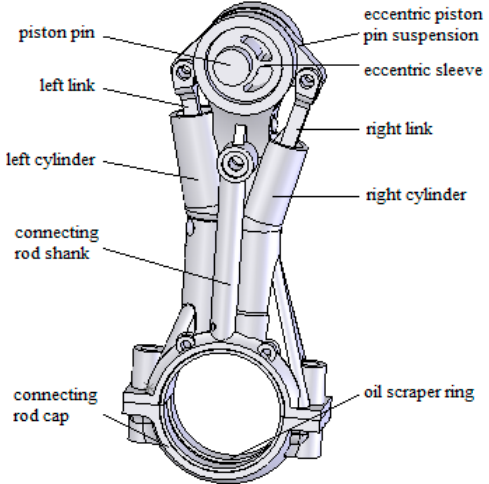
Figure 1. Structure of the connecting rod.